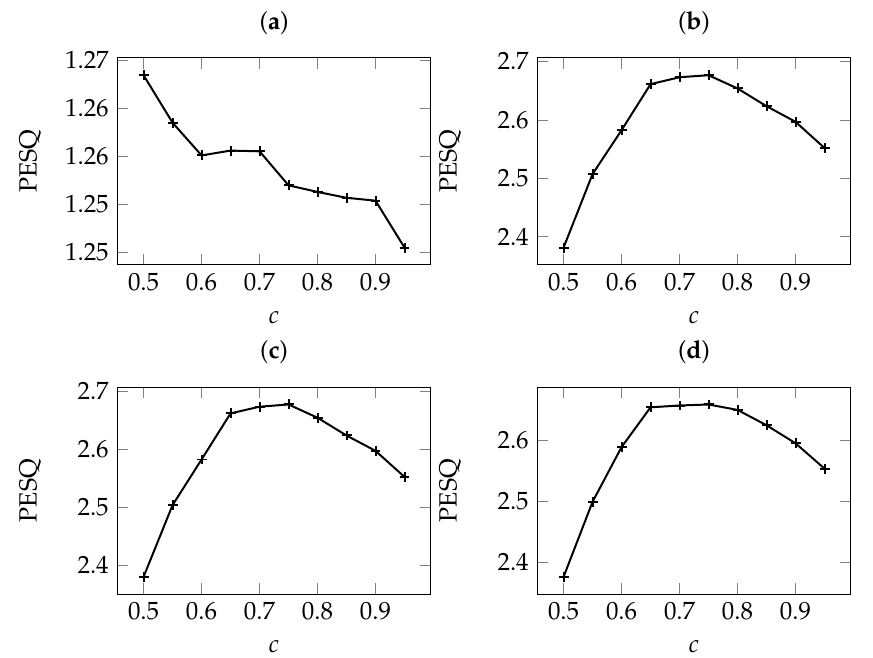
Figure 4. The performance of the proposed method (perceptual evaluation of speech quality (PESQ)) when the adaptation speed c was varied for various communication channels: ( a ) GSM, ( b ) IMA-ADPCM, ( c ) PCM, and ( d ) Microsoft-ADPCM. The results are the average PESQ scores over all 20 utterances.